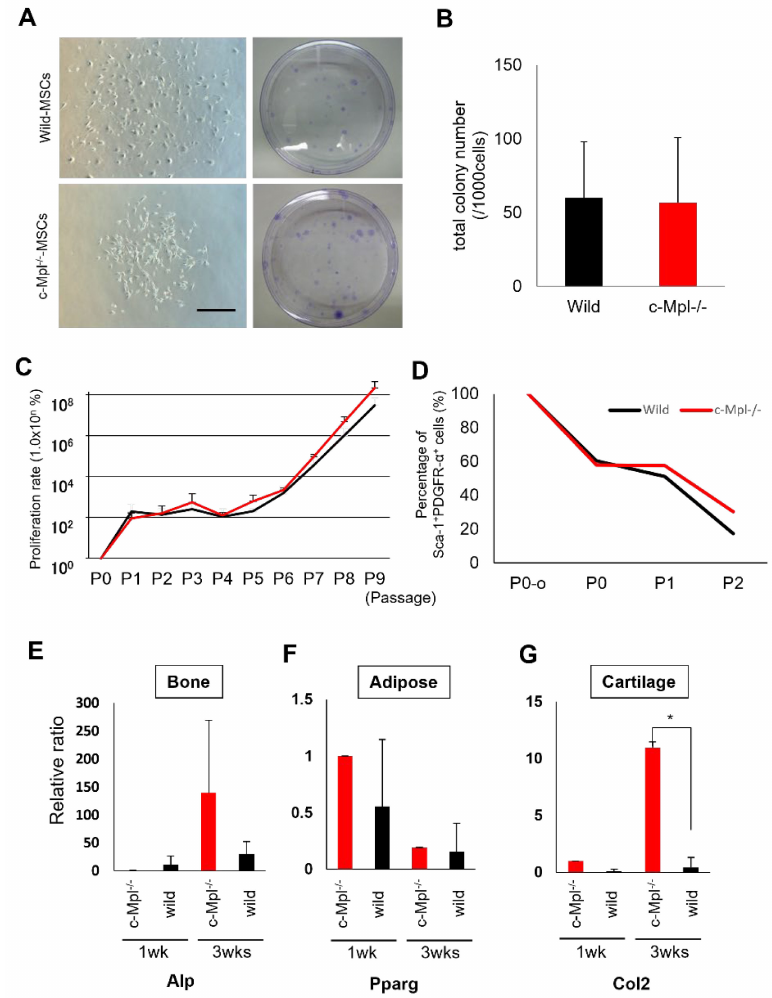
Figure 4. c-Mpl-deficient MSCs have normal proliferation and differentiation potential. ( A ) Phase- contrast images of cultures of c-Mpl-WT and c-Mpl-KO MSCs (left panels) and cells after 14 days of culture in CFU-F assay (right panels, 100 mm dishes). ( B ) Total numbers of CFU-Fs counted on day 14 ( n = 15). Scale bar = 1 mm. ( C ) Growth curves for wild-type and c-Mpl − / − mouse- derived MSCs ( n = 3 per group). ( D ) Percentages of PDGFR- α - and Sca-1-positive cells in the cul- tured cells. ( E – G ) Real-time PCR analysis of tri-lineage marker expression (mAlp, ( E ); mPparg, ( F ); mCol2, ( G )) in MSCs following 1- and 3-week treatments with mesenchymal differentiation media. * p < 0.05 c-Mpl − / − MSCs vs. wild-type MSCs ( n =